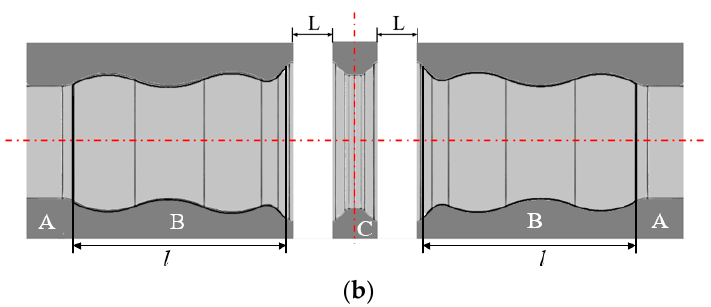
Figure 2. Cross-sectional configurations of designed die set. ( a ) Traditional die set; ( b ) Movable die set.